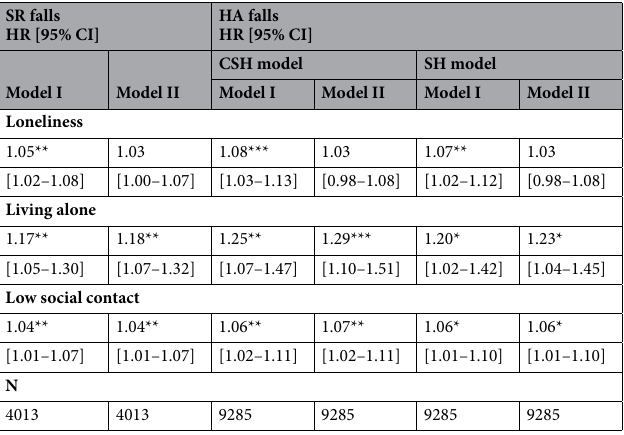
Table 2. Results from survival analysis models for self-reported (SR) and hospital admission (HA) cohorts. Model I controlled for socio-demographic covariates; Model II controlled for socio-demographic, health and